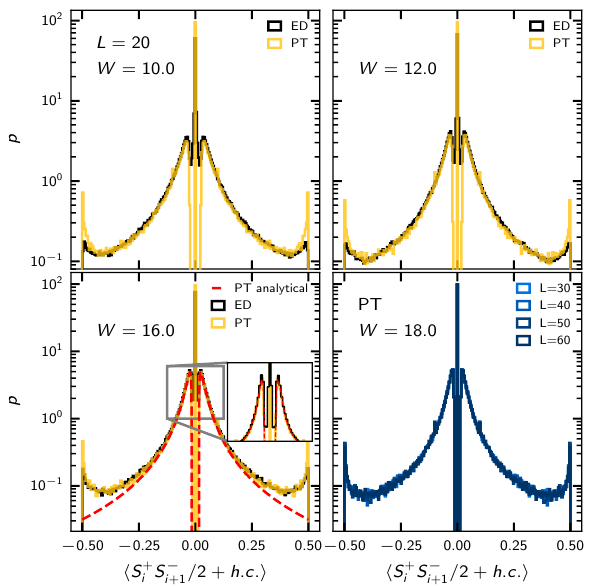
/ 2 + h . c . 〉 compared the ex- S − i + 1 i